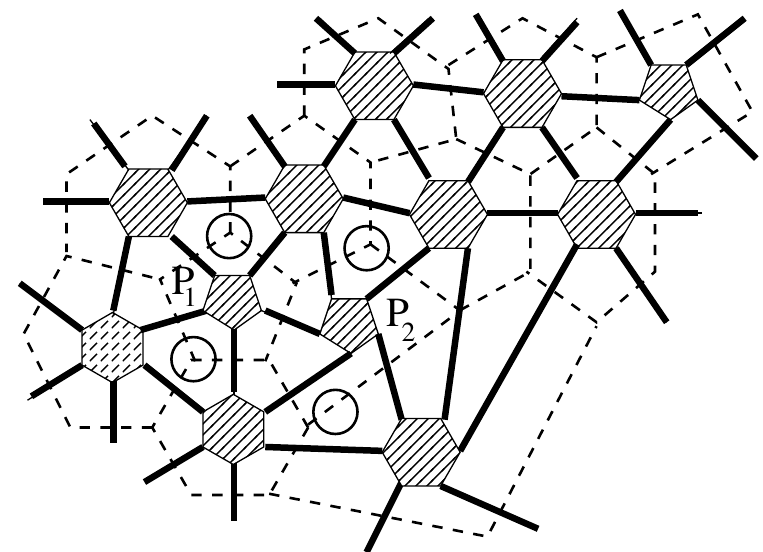
Figure 1. A portion of a leapfrog